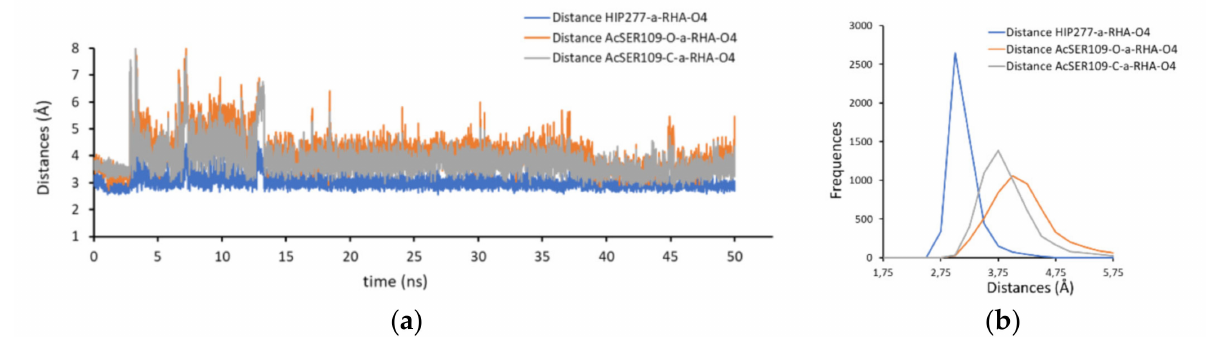
Figure 9. ( a ) Distance values relative to the starting structure along 50 ns of MD simulation of PSL complexed to α -rhamnose ( 8 ). The Y axis shows the distances values in Å and the X axis is the time in nanoseconds. ( b ) Distribution of the distance values along the simulation. In both charts, distance values between HIS-277 and C-4 hydroxyl group of α -rhamnose are represented in blue, between ester oxygen of laurated-SER-109 and C-4 hydroxyl group of α -rhamnose in orange, and between ester carbon of laurated-SER-109 and C-4 hydroxyl group in grey.